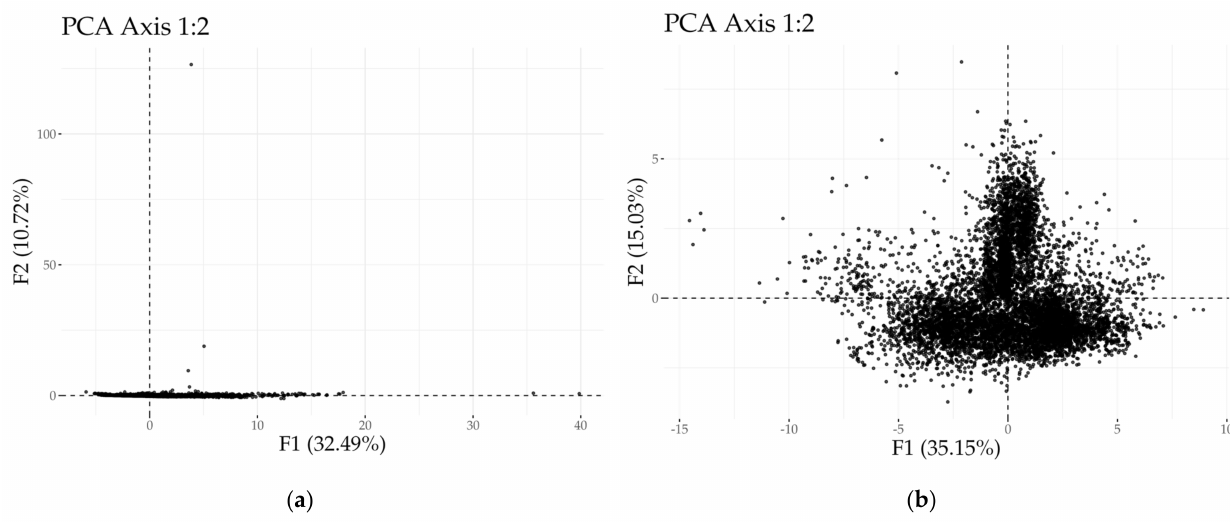
Figure 3. Inertia of the factorial axes of the PCA conducted on the raw and log-transformed data.